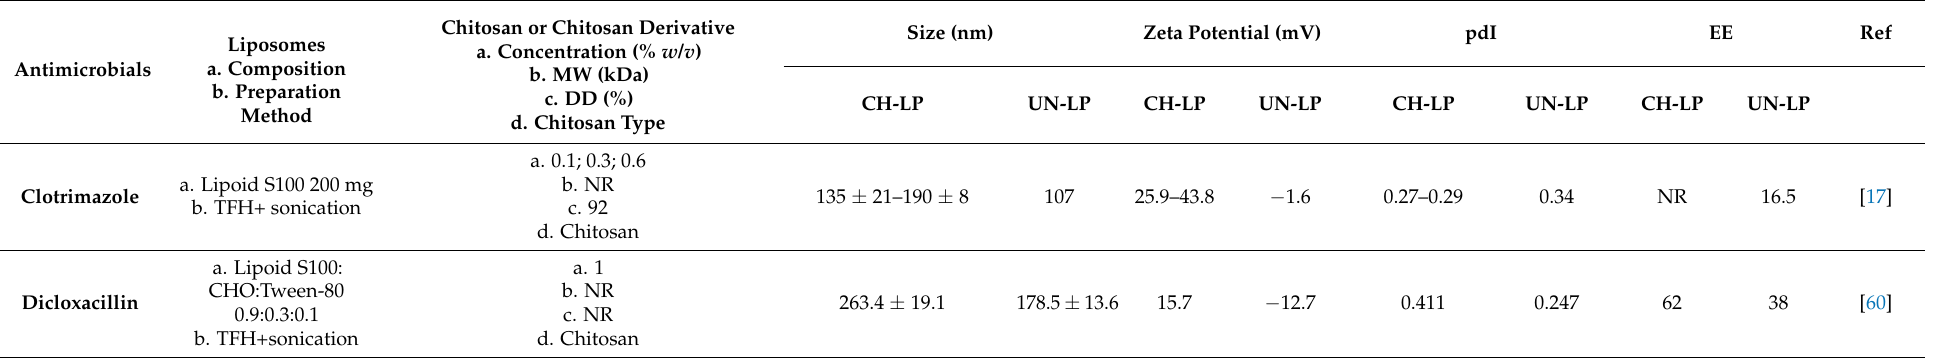
Table 3. Comparison of size, surface charge, homogeneity and drug EE between liposomes and chitosomes loading antimicrobials. The liposomal composition is indicated in the table in molar ratio except when * exists, indicating a weight ratio ( w/w